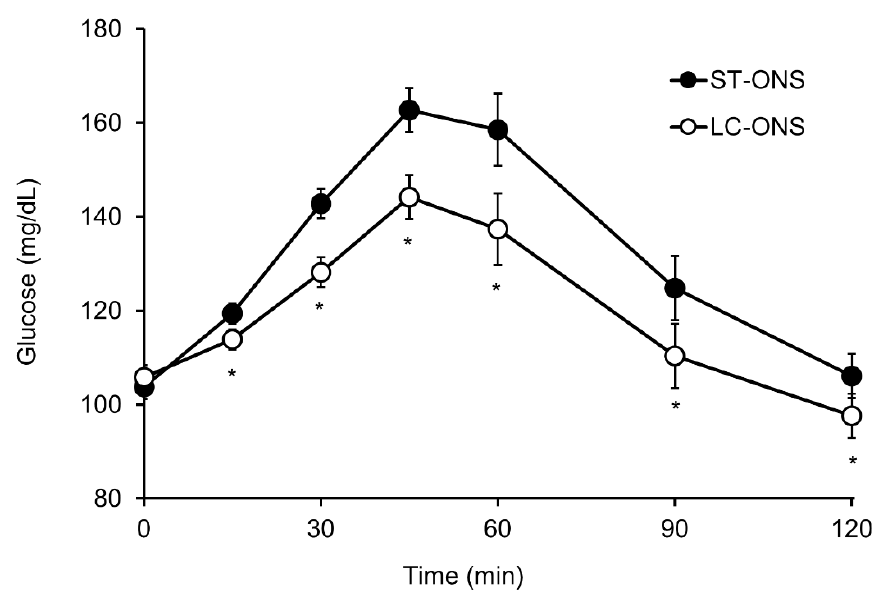
Figure 2. Postprandial levels of glucose after ingestion of a low-carbohydrate-type oral nutritional supplement (LC-ONS) or a standard-type ONS (ST-ONS) ( n = 20). Values are expressed as the least mean square value ± standard error; * p < 0.05 comparing ST-ONS vs LC-ONS.